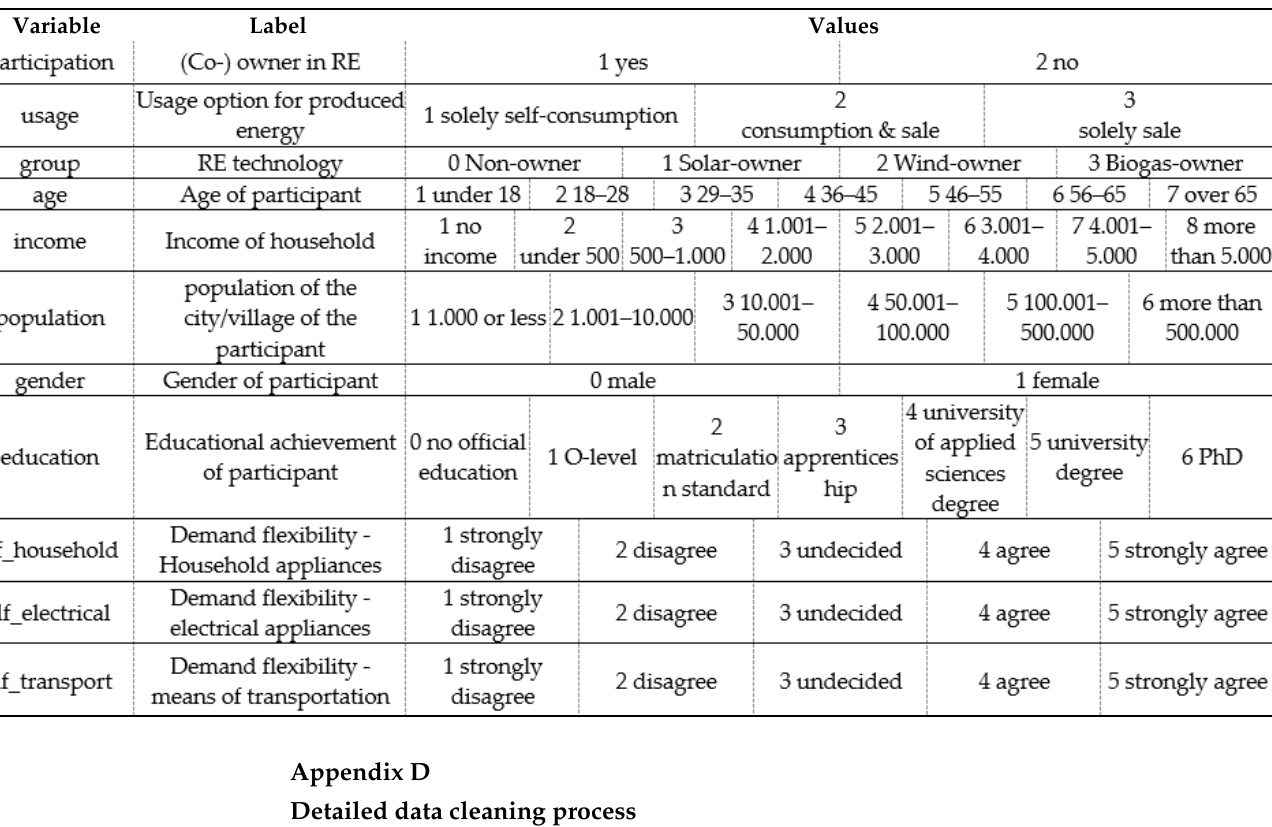
Table A2. Depiction of variable names, labels and values for all variables used to produce the results.